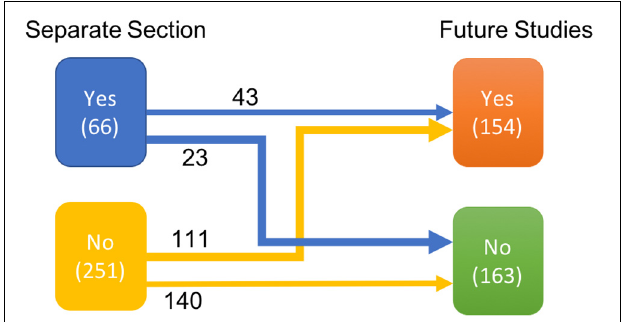
FIGURE 4 | Connection separate section and recommendations for future